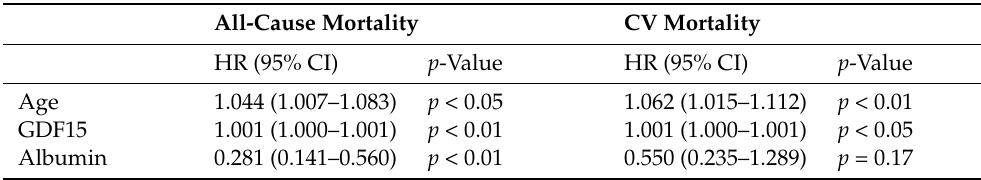
Table 3. Age, GDF15, and albumin as significant prognostic parameters for all-cause mortality in the multivariate Cox regression